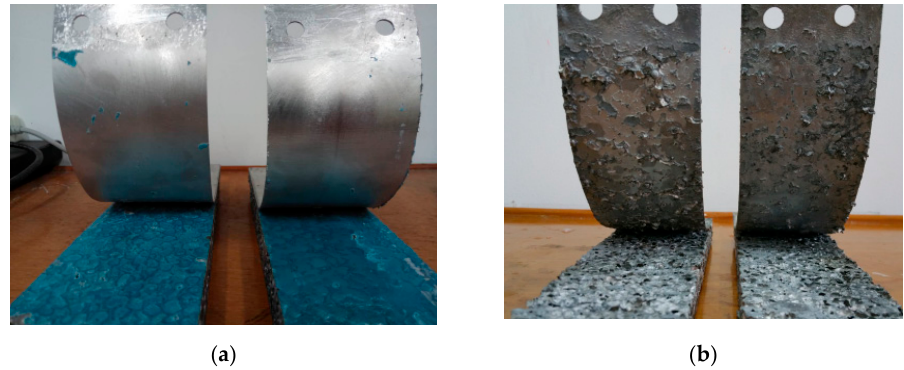
Figure 6. Appearances of Peel Fractures of two types of samples ( a ) Adhesive joining samples ( b ) Metallurgical joining samples.